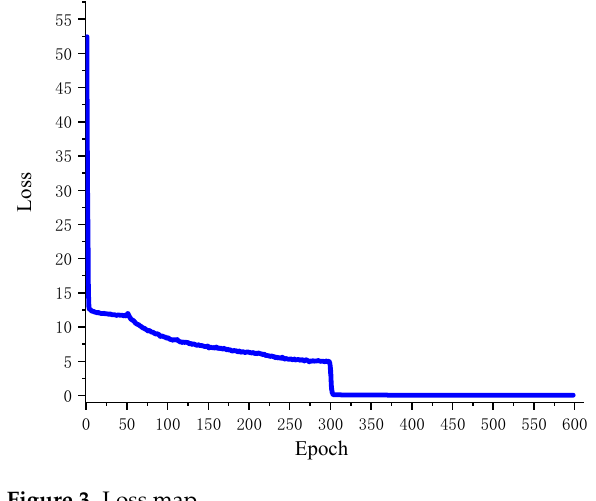
Figure 3. Loss map . Figure 3. Loss map.